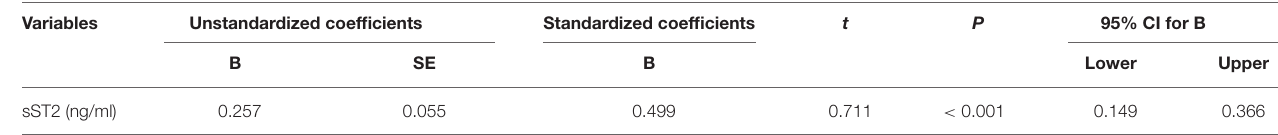
TABLE 4 | Multivariate linear regressions for the correlations between baseline sST2 and LAVI in persistent AF patients. Variables Unstandardized